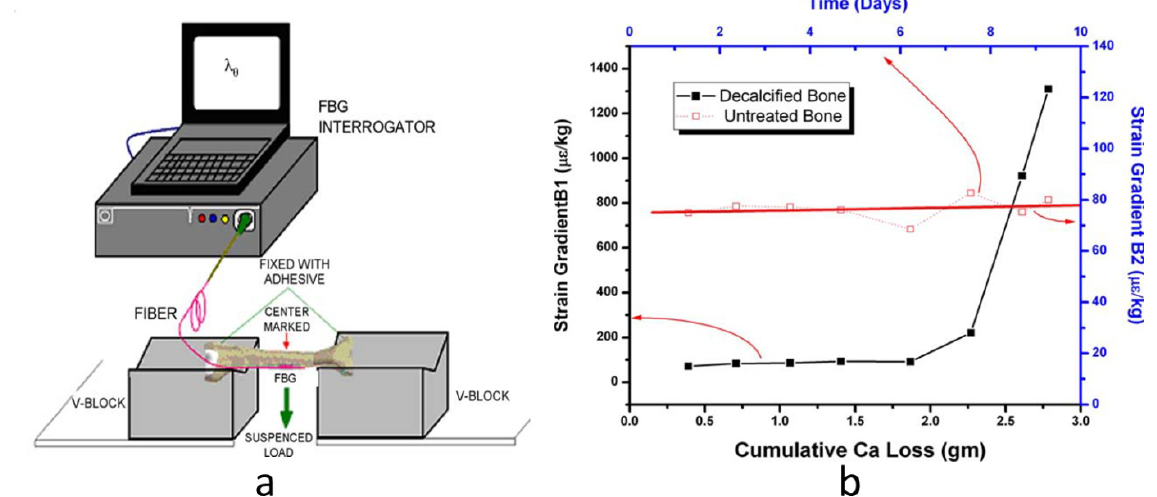
Figure 3. ( a ) The schematic of experimental set-up. ( b ) The comparison between strain response of decalcified and untreated bones